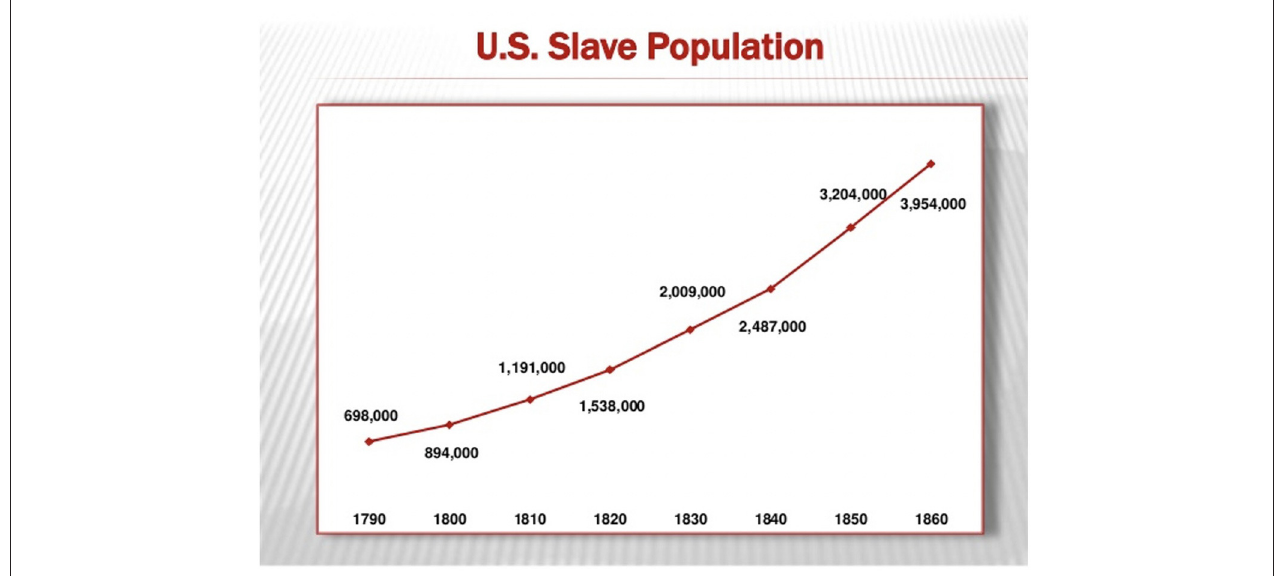
FIGURE 1 | Trajectory of the Slave Population in the United States (U.S.) from 1790 until 1860. This figure used with permission from (copyleft 2007) Chad David Cover. Data derived from “Series A 119–134. Population by Age, Sex, Race, and Nativity: 1790–1970.” U.S. Bureau of the Census, Historical Statistics of the United States, Colonial Times to 1970. Bicentennial Edition, Part 2. Washington, D.C.,